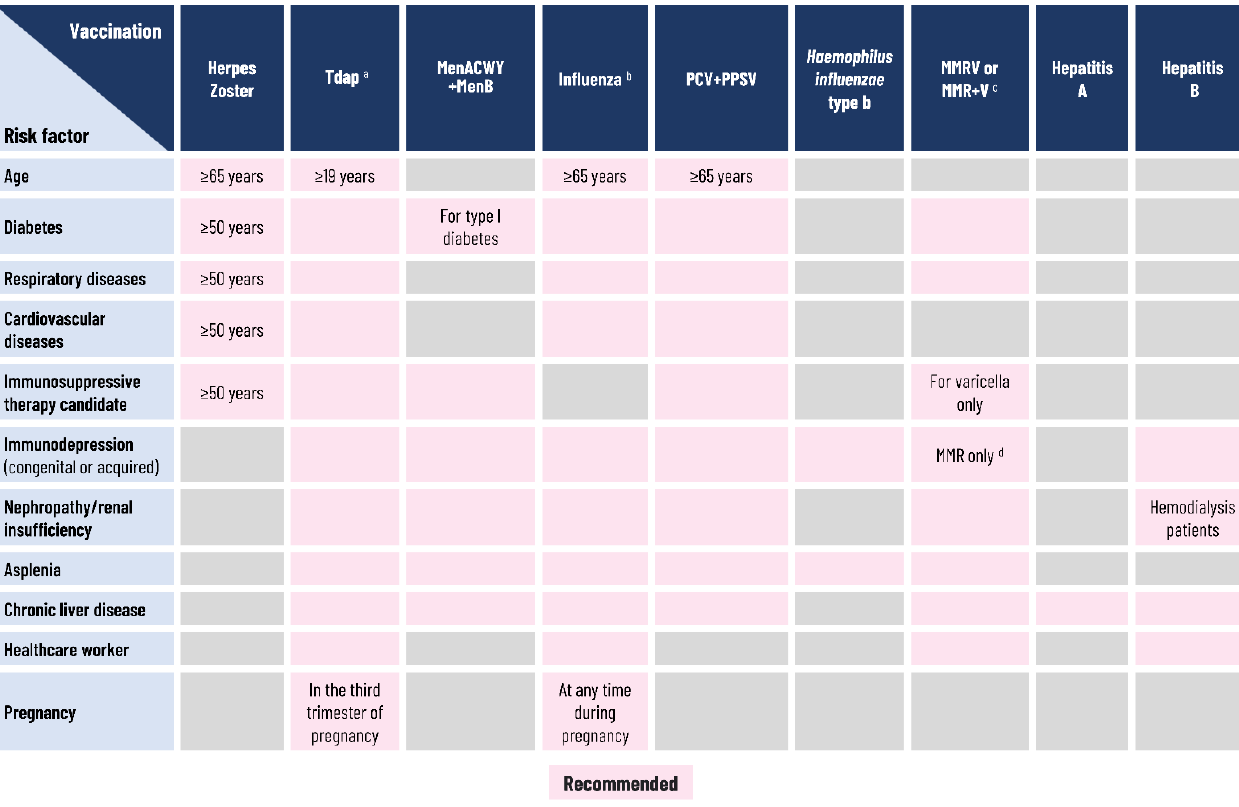
Figure 5. Recommended vaccinations for Italian adults. a One dose every 10 years; b One dose per year; c Susceptibility of adults to these diseases should be checked and vaccination offered if susceptible. Susceptible women should be vaccinated ≥1 month before pregnancy; d Immunosuppression with CD4 lymphocyte count ≥ 200/mL. Abbreviations: CD4, cluster of differentiation 4; MenACWY, meningococcal vaccine against meningococcal disease due to serogroups A, C, W, and Y; MenB, meningococcal vaccine against meningococcal disease due to serogroup B; MMR, measles, mumps, and rubella vaccine; MMRV, measles, mumps, rubella, and varicella vaccine; PCV, pneumococcal conjugate vaccine; PPSV, pneumococcal polysaccharide vaccine; Tdap, tetanus toxoid, reduced diphtheria toxoid, and acellular pertussis vaccine; V, varicella vaccine. Source: Piano Nazionale Prevenzione Vaccinale 2017 – 2019 ( National Immunization Plan 2017 – 2019) [20].